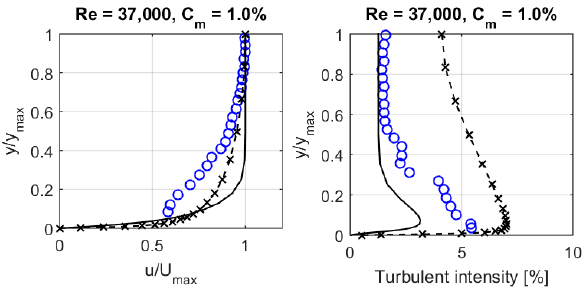
Figure 8. Normalised velocity profiles ( left ) and turbulent intensity profiles ( right ) for fibre suspension consistency 1% and Reynolds number 37,000 for the Bingham model ( − ), the ODF model (-- × ) and the experiments (o) from Xu and Aidun (2005) [27].